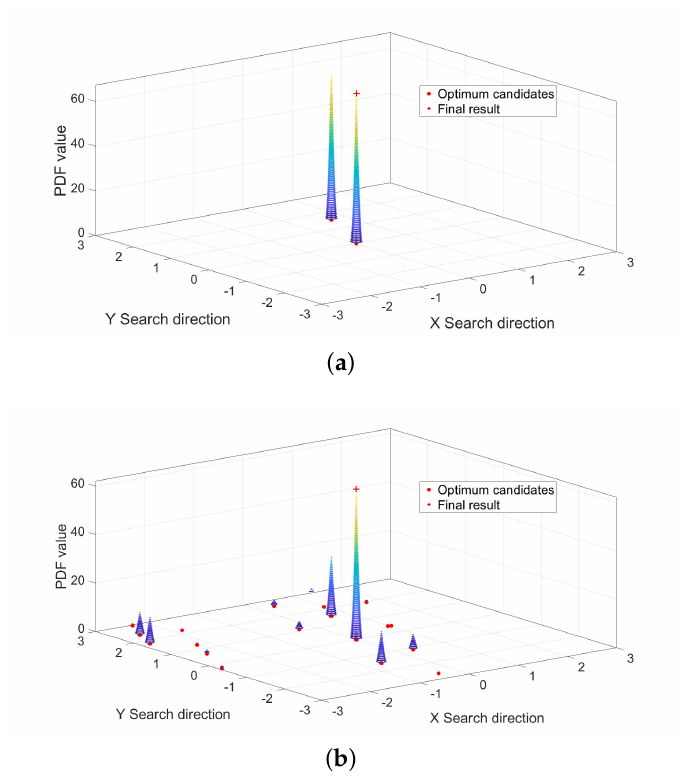
Figure 9. Probability density function (PDF) value of different Epochs. ( a ) PDF value of Epoch 2. ( b ) PDF value of Epoch